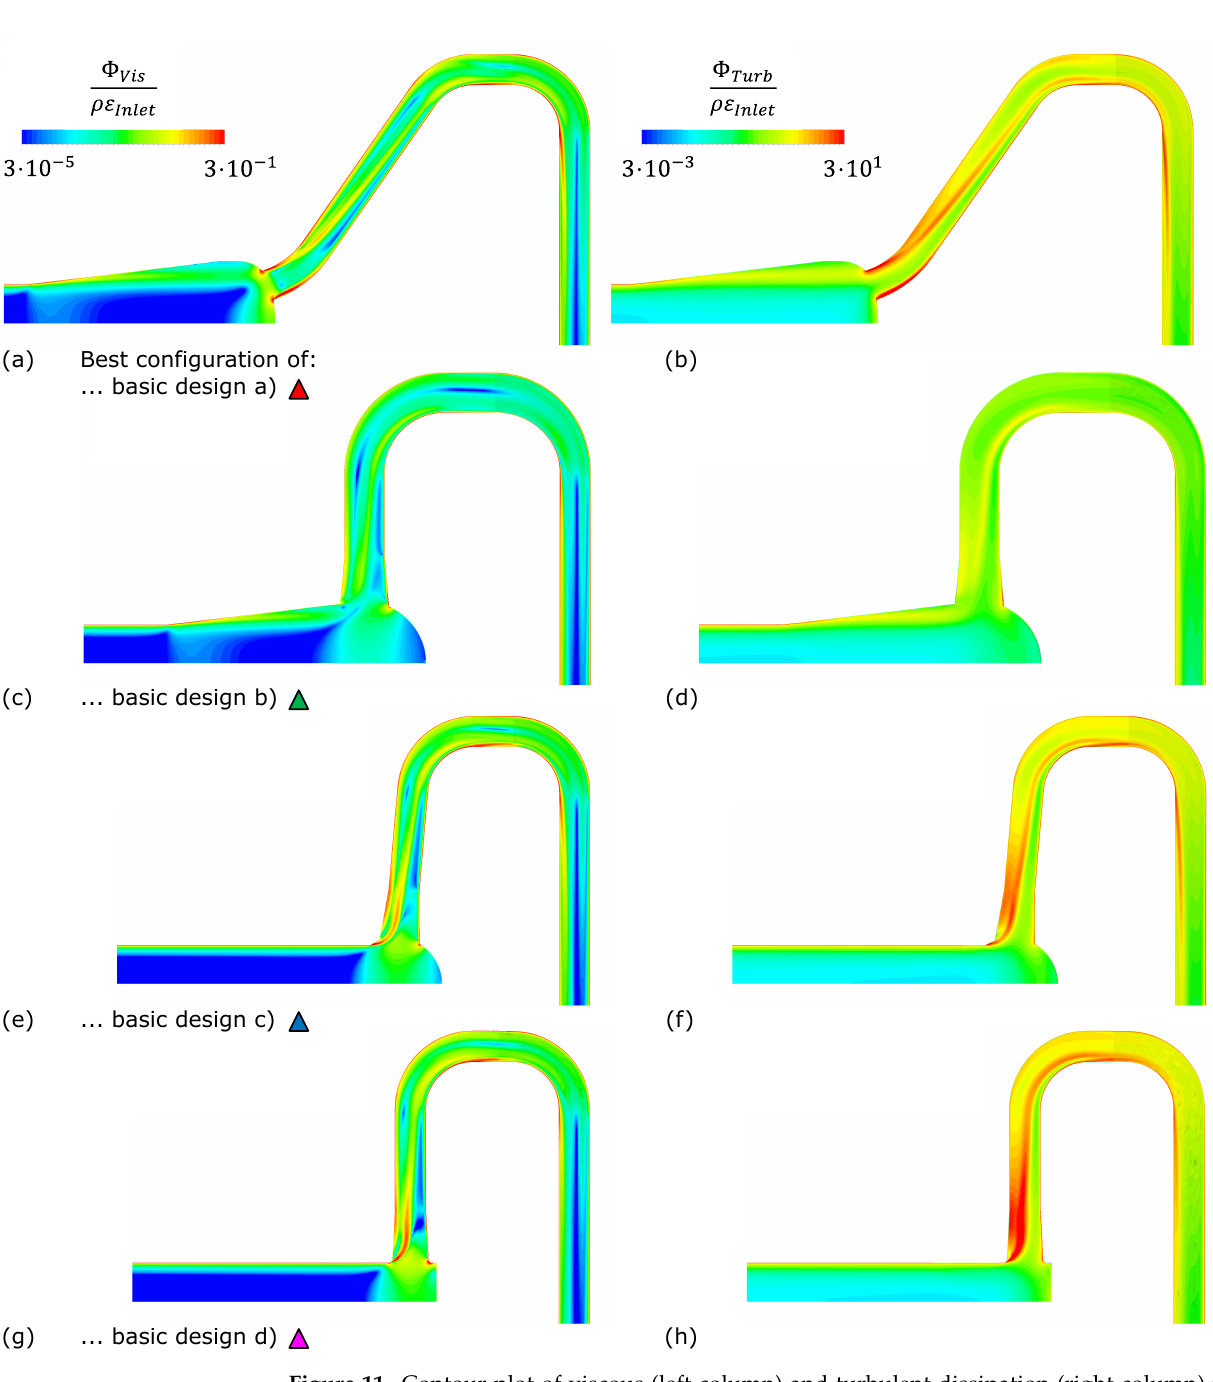
Figure 11. Contour plot of viscous (left column) and turbulent dissipation (right column) in the mid-plane of the best configurations of the four basic designs. The quantities are normalised by the density-weighted turbulent eddy dissipation at the inlet. Subfigures ( a , b ) show basic design a), ( c , d ) show basic design b), ( e , f ) show basic design c), ( g , h ) show basic design